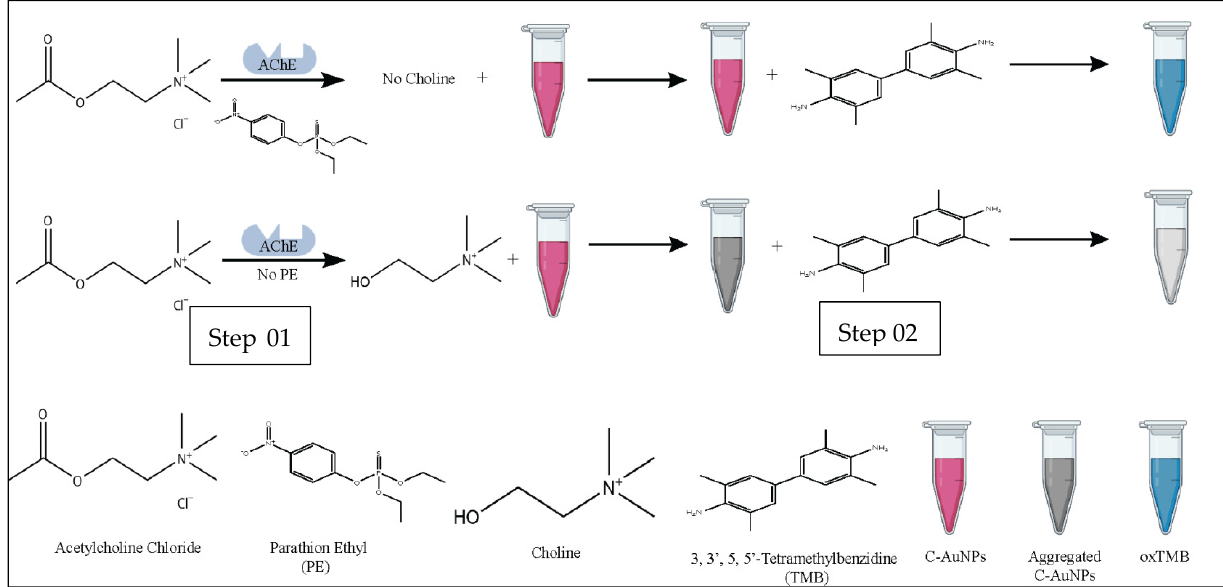
Figure 1. Schematic representation of colorimetric detection of PE via C-AuNPs. Step 01 represents the effect of PE on the formation of choline. Step 02 represents the oxidation potential of dispersed and aggregated C-AuNPs.